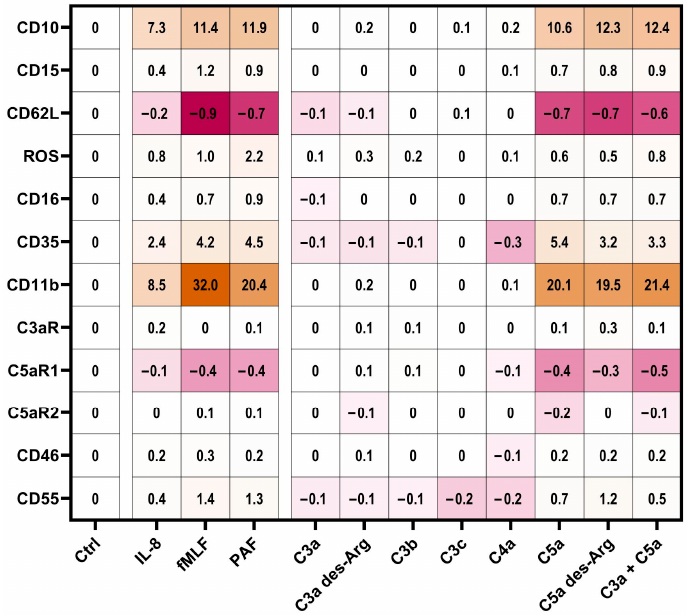
Figure 5. Changes after exposure to complement cleavage products of the neutrophil complement- related receptors and regulators with respect to ( a ) CD35, ( b ) CD11b, ( c ) C3aR, ( d ) C5aR1, ( e ) C5aR2, ( f ) CD46, and ( g ) CD55. Y-axis reports median fluorescence intensity (MFI). The following concentrations were used: 10 nM C5a, 10 nM C5a des-Arg, 10 µ M fMLF, 50 ng/mL IL-8, 100 nM. *, **, and *** = p < 0.05, < 0.01, and < 0.001, respectively. Kruskal–Wallis test with uncorrected Dunn’s test.